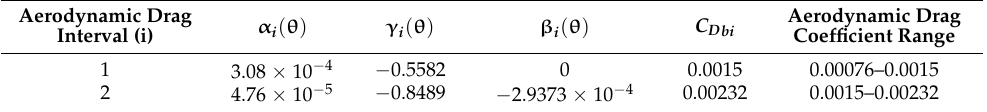
Table 5. The MADP-S1 power approximation coefficients for the aerodynamic drag coefficient retrieval (NRCS with values greater than 0.0079 ( − 21.4